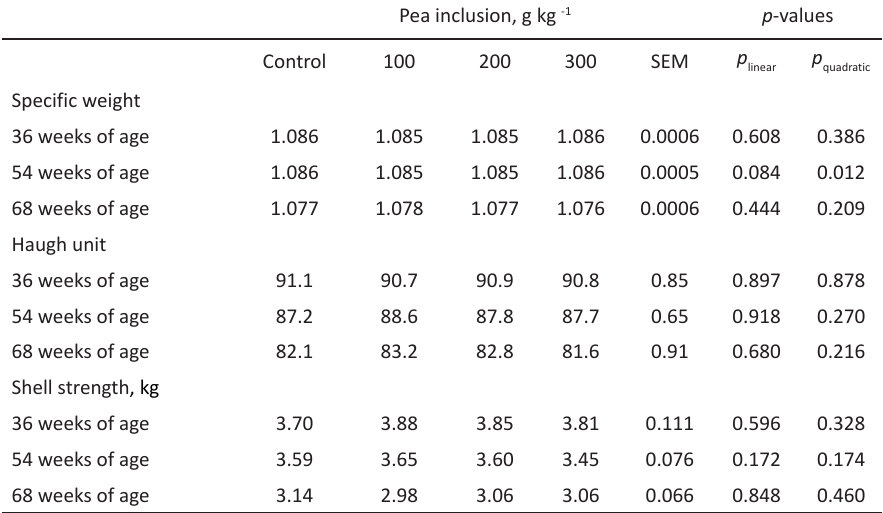
Table 6. The effects of dietary inclusion level of peas on egg quality variables 1 Pea inclusion, g kg -1 p